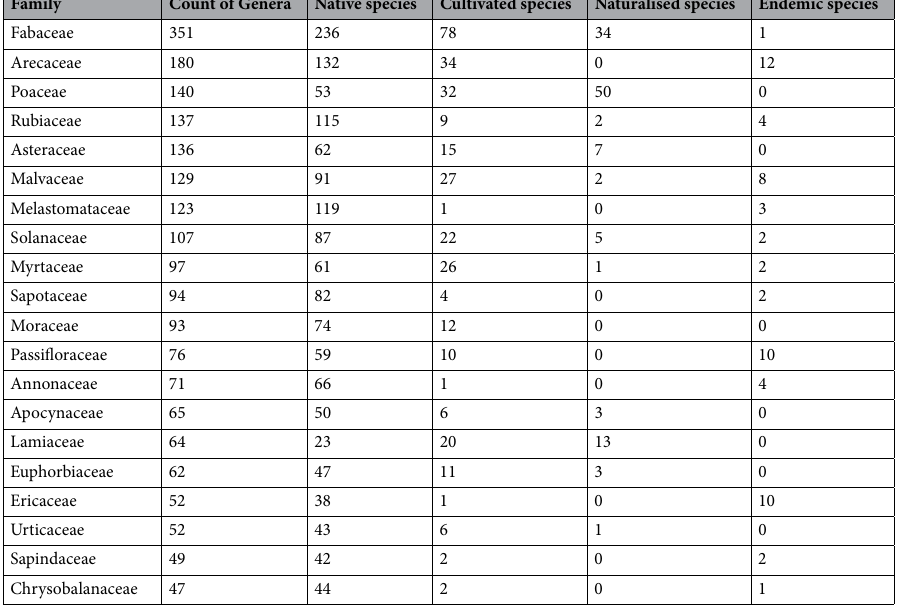
Table 1. Top 20 families per number of genera recorded in Colombia, with count of native, cultivated, naturalised and endemic